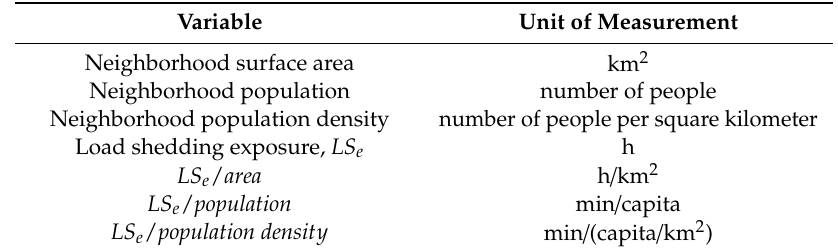
Table 1. Normalizing and transformed variables for assessing neighborhood load shedding